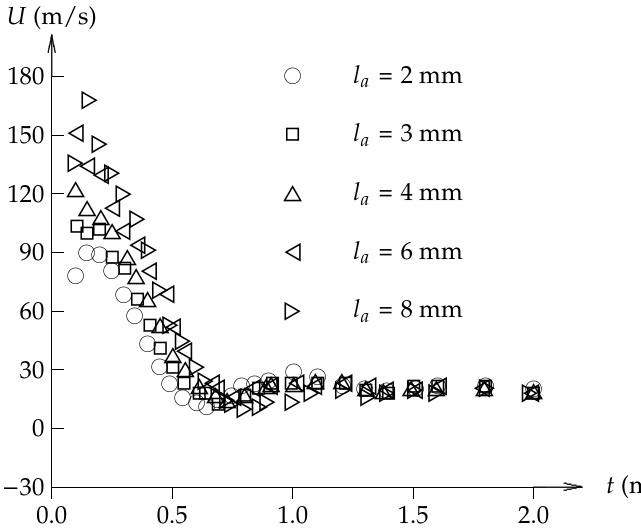
Figure 29. Jet exit velocity versus time. Figure 27. Jet exit velocity versus time.